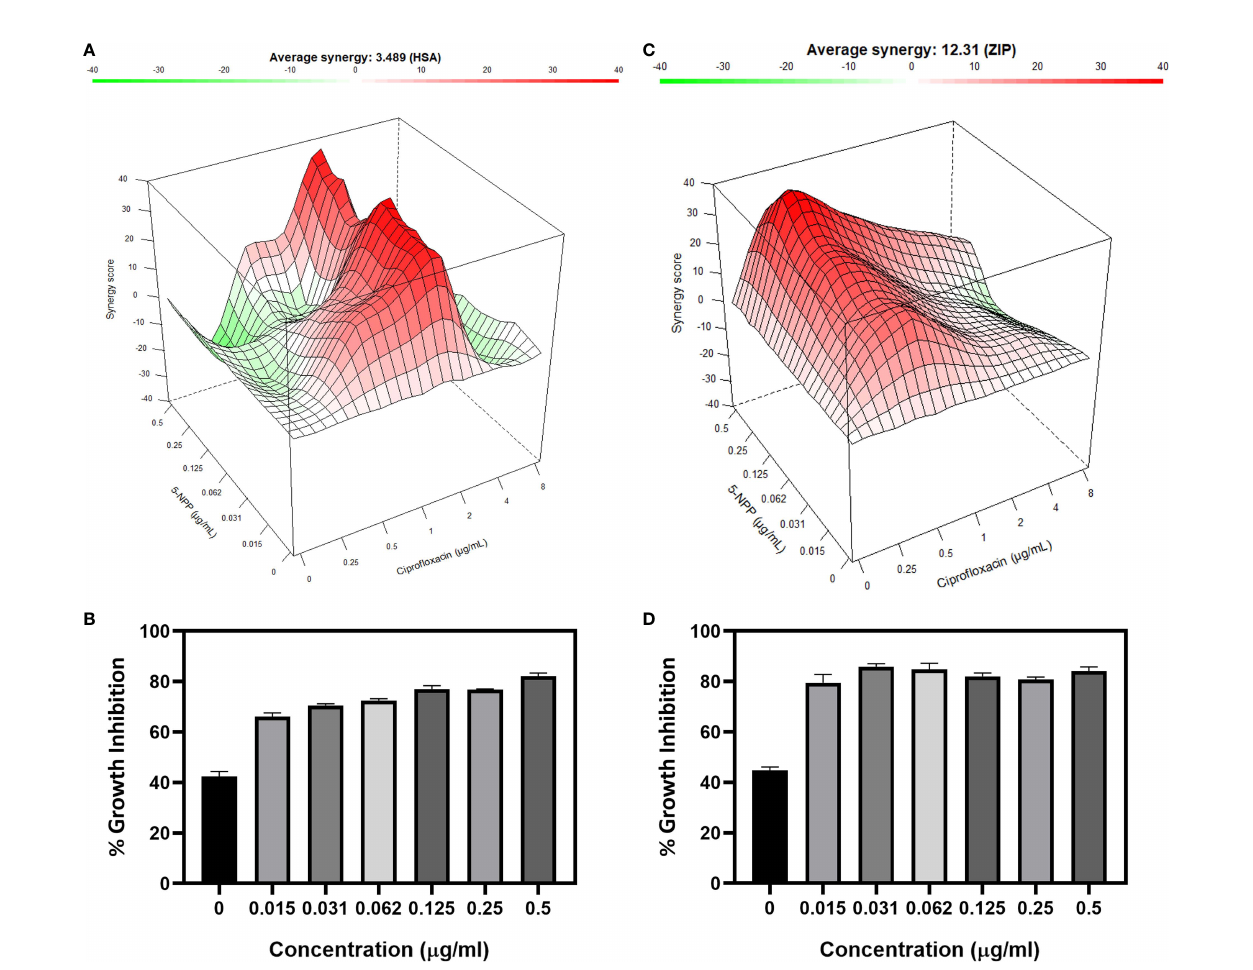
FIGURE 4 | Effect of 5-NPPP in enhancing the bactericidal potential of cipro fl oxacin. (A) Synergy plot of Sa -P2003 at varying concentrations of cipro fl oxacin and 5- NPPP. The synergy score of 3.489 (Highest Single Agent model) shows additive. (B) For Sa -P2003, at the constant concentration of cipro fl oxacin (0.5 µg mL − 1 ), the concentration-dependent growth inhibitory activity of 5-NPPP is shown. (C) Synergy plot of SA-1199B at varying concentrations of cipro fl oxacin and 5-NPPP. The zero-interaction potency model was used to fi t the synergy data having the synergy score of 12.31, which shows synergism. (D) For SA-1199B, at the constant concentration of cipro fl oxacin (0.5 m g mL − 1 ), the potentiation activity of 5-NPPP was established at the minimum concentration of 0.015 µg mL − 1